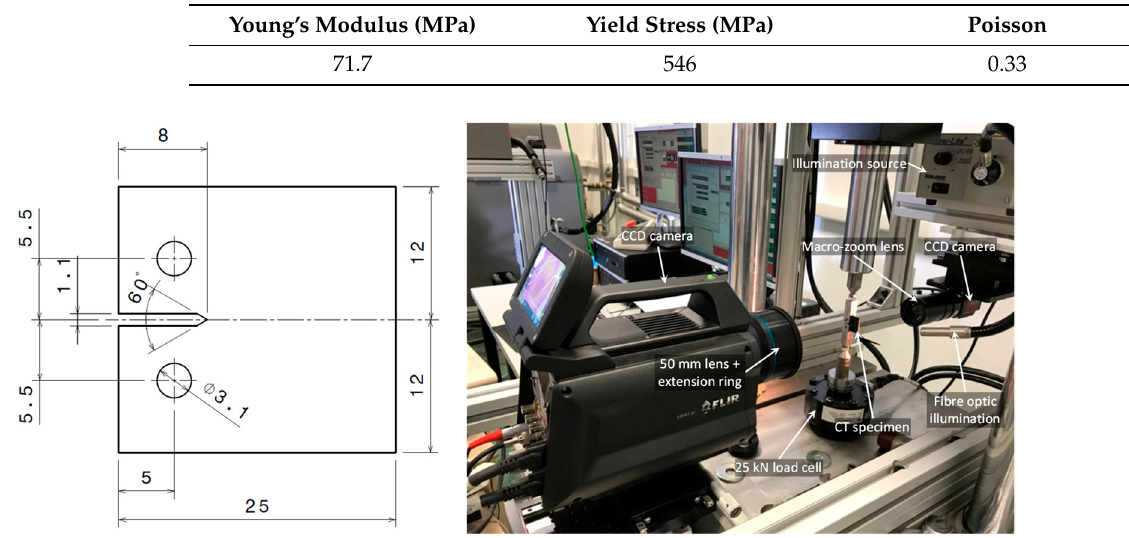
Figure 2. ( Left ) Dimensions (mm) of the CT specimen [12] tested in the lab. ( Right ) Experimental set-up for fatigue testing and data acquisition.